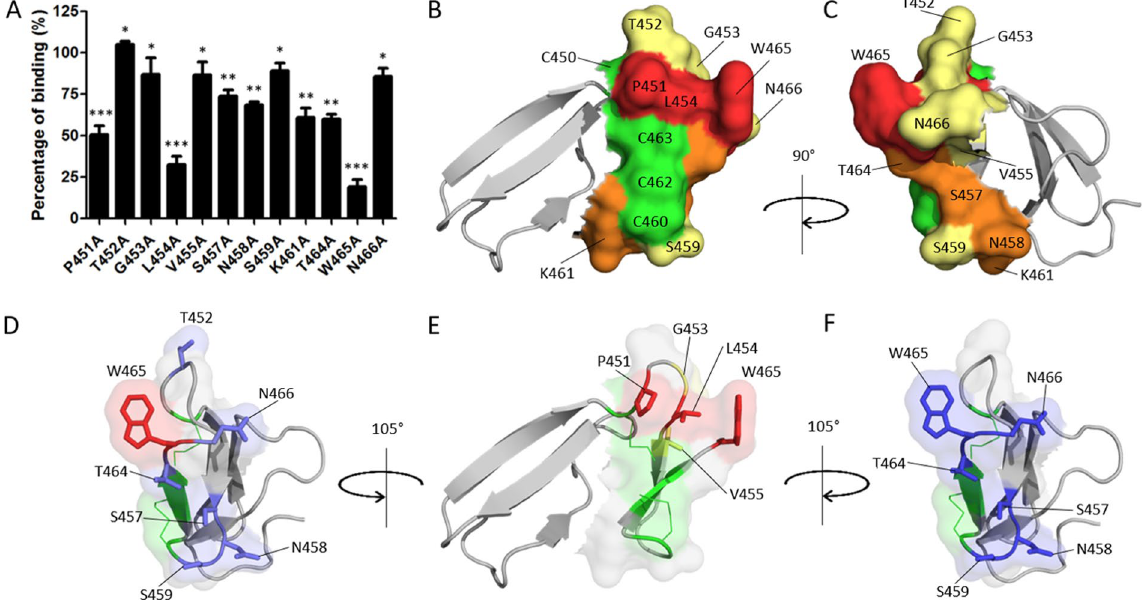
Figure 3. Molecular mechanism of chitin binding and structural features of ChBD CHIT1-49 . ( A ) The diagram shows the chitin binding efficiencies of single mutants generated by directed mutagenesis of predicted binding residues. All the protein mutants (except T452A) displayed reduced binding activities and were classified in three different groups depending on the impact of the mutation: (i) low impact * , (ii) medium impact ** and (iii) high impact *** . ( B ) X-ray 3D structure of ChBD CHIT1-49 solved by Fadel and coworkers (PDB ID: 5HBF) where the “hevein-fold” motif is shown in surface representation whereas the rest of the structure is represented in cartoon (disulphide bonds are colored in green). Mutated residues were colored in yellow, orange and red depending respectively on the low, medium and high impact of the mutation on the chitin binding function. ( C ) 90° rotated view of the structure. ( D ) Detailed view of polar residues (in blue sticks) and Trp465 (in red) in the “hevein-fold” motif of ChBD CHIT1-49 (disulphide bonds in green). ( E ) Representation of key residues (P451, G453, L454 and V455) involved in the hydrophobic pocket which stabilises Trp465 orientation (disulphide bonds in green). ( F ) Surface representation of the binding surface of ChBD CHIT1-49 highlighting the key aromatic residue Trp465 and the key polar residues S457, N458, S459, T464 and N458 (blue sticks) directly involved in chitin binding (disulphide bonds in